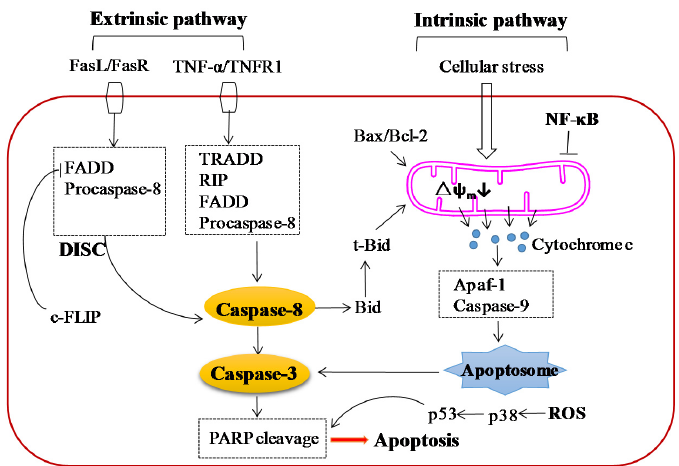
Figure 4. Apoptosis signaling pathways induced by icariin and icariside II. Icariin and icariside II induce apoptosis of tumor cells through two pathways, extrinsic (receptor ‐ mediated) pathway